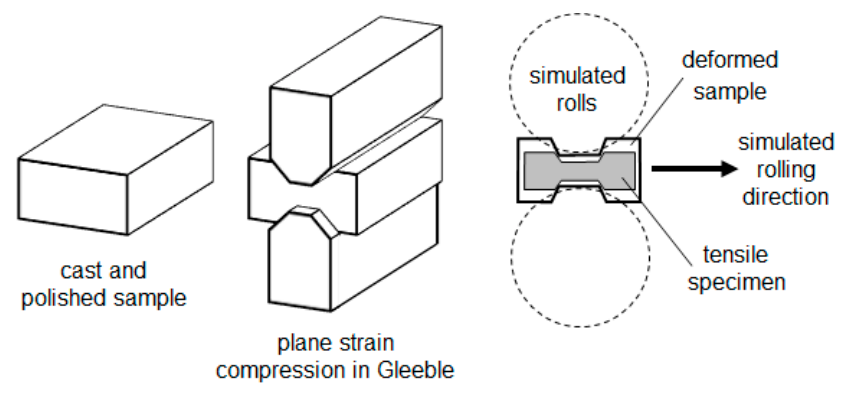
Figure A1. Representative optical images of microstructures in as-received samples of ( a ) Ti-steel and ( b ) MoNbTi-steel. Metals 2018 , 8 , x FOR PEER REVIEW 14 of 17